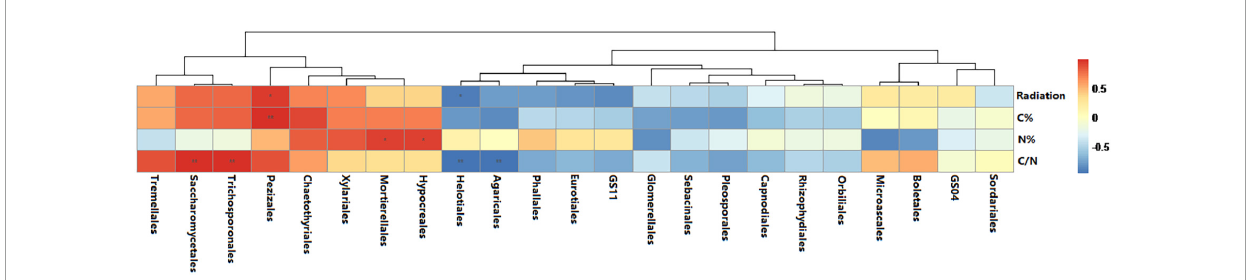
FIGURE7 Relationships between the dominant species (at order level) that exhibited higher relative abundance and the radiation intensity, carbon content, nitrogen content, and C/N ratio. The lines represent the relationships from cluster analysis of species/OTUs. Color depth represents the level of